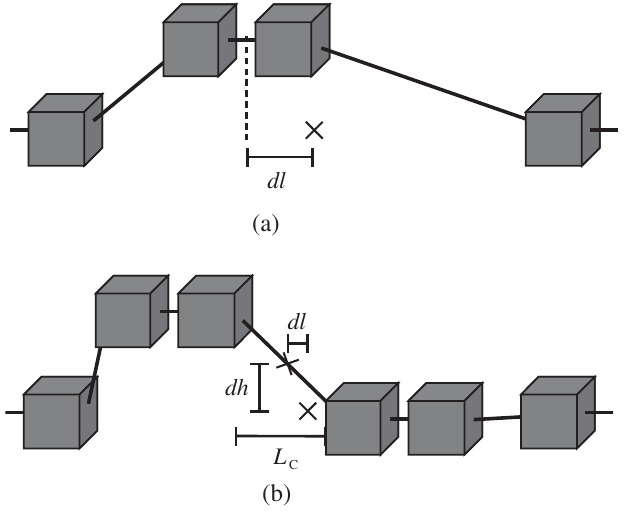
FIG. 5. Free geometric parameters in the scans of the C- chicane (a) and S-chicane (b).